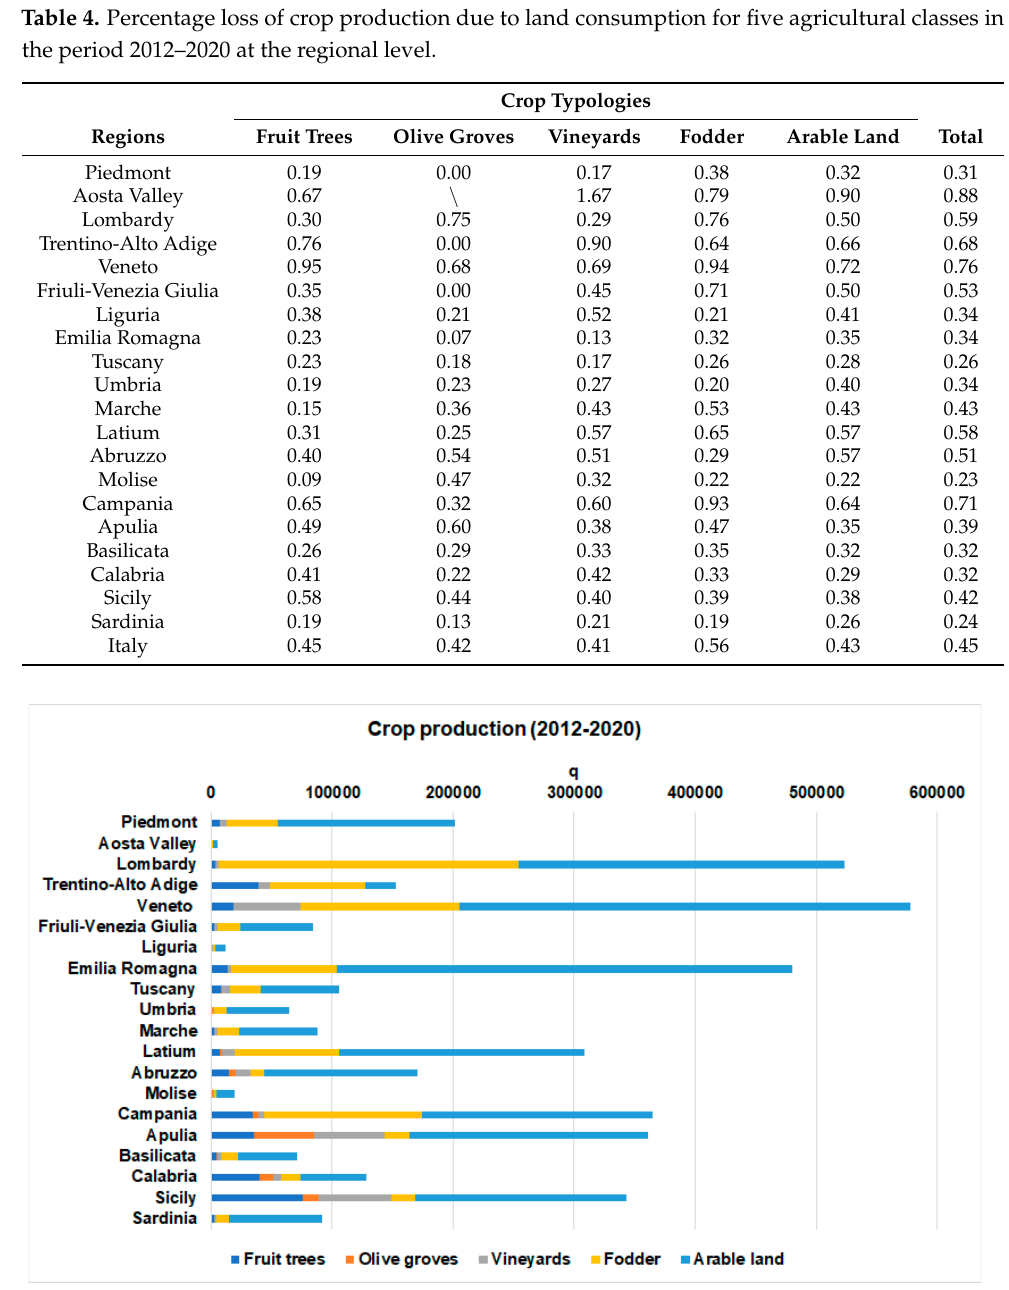
Figure 5. Estimation of crop production loss (quintals) due to land consumption for five agricultural classes in the period 2012–2020 at the regional level. classes in the period 2012–2020 at the regional